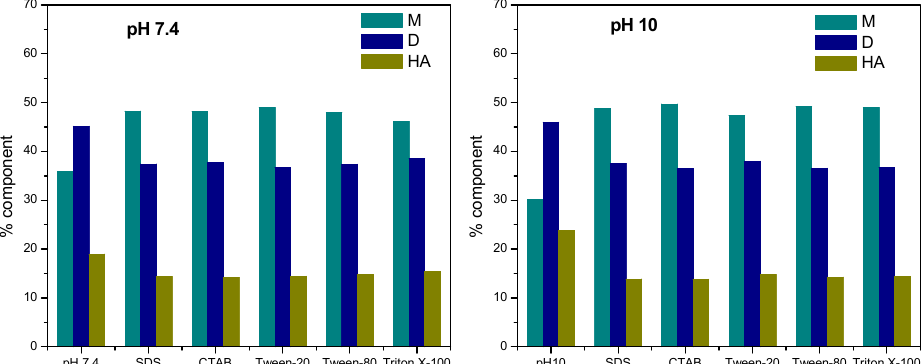
Figure 5. Variation of the percent of component band areas in deconvoluted spectra for monomer (M), dimer (D) and higher aggregates (HA) of mitoxantrone in phosphate buffer pH 7.4, carbonate buffer pH 10 and micellar concentrations of SDS (8.64 × 10 − 3 M), CTAB (3.88 × 10 − 3 M), Tween-20 (3.12 × 10 − 2 M), Tween-80 (3.46 × 10 − 2 M) and Triton X-100 (2.68 × 10 − 2 M).